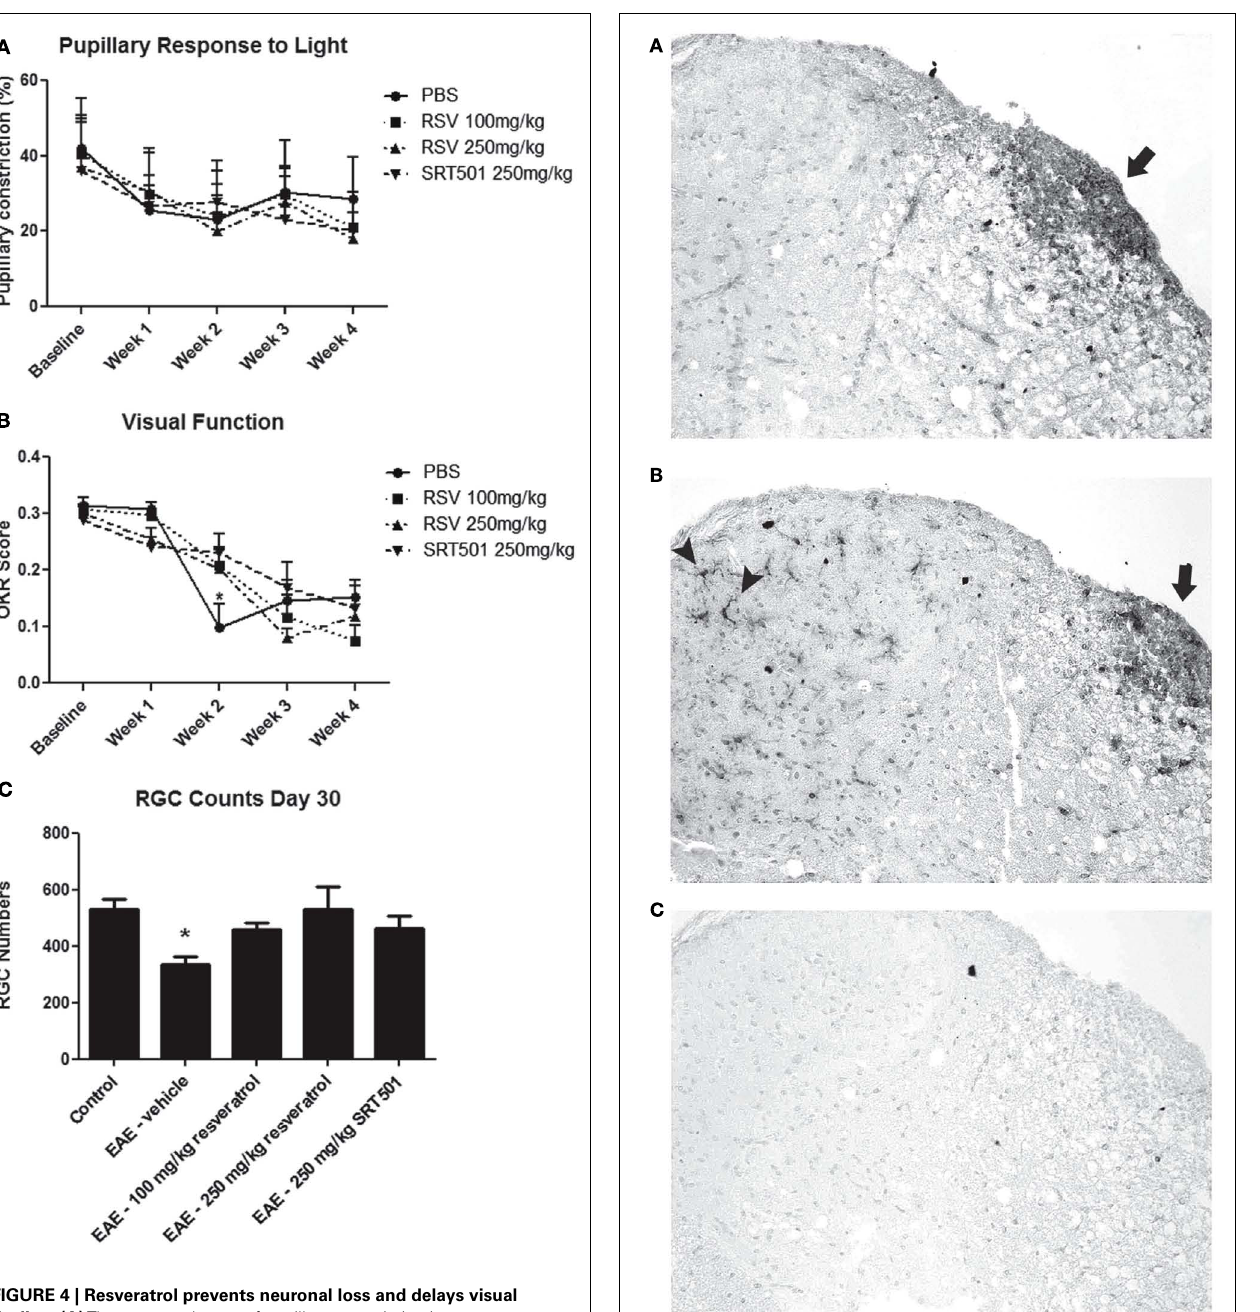
FIGURE 4 | Resveratrol prevents neuronal loss and delays visual decline. (A) The average degree of pupillary constriction in response to flashes of light measured by pupillometry decreased over the first 2weeks after immunization in EAE mice, with no difference between EAE mice treated with PBS, 100mg/kg RSV, 250mg/kg RSV, or 250mg/kg SRT501. (B) Visual function, measured by OKR responses, was significantly reduced in EAE mice treated with PBS as compared to those treated with either 100mg/kg RSV, 250mg/kg RSV, or 250mg/kg SRT501 at 2weeks post-immunization (* p < 0.05). (C) At day 30 post-immunization, there was a significance decrease in the number of RGCs counted in each retina of EAE mice treated with PBS (vehicle) alone, as compared to control, non-EAE mice, and compared to EAE mice treated with RSV or SRT501 (* p < 0.05).